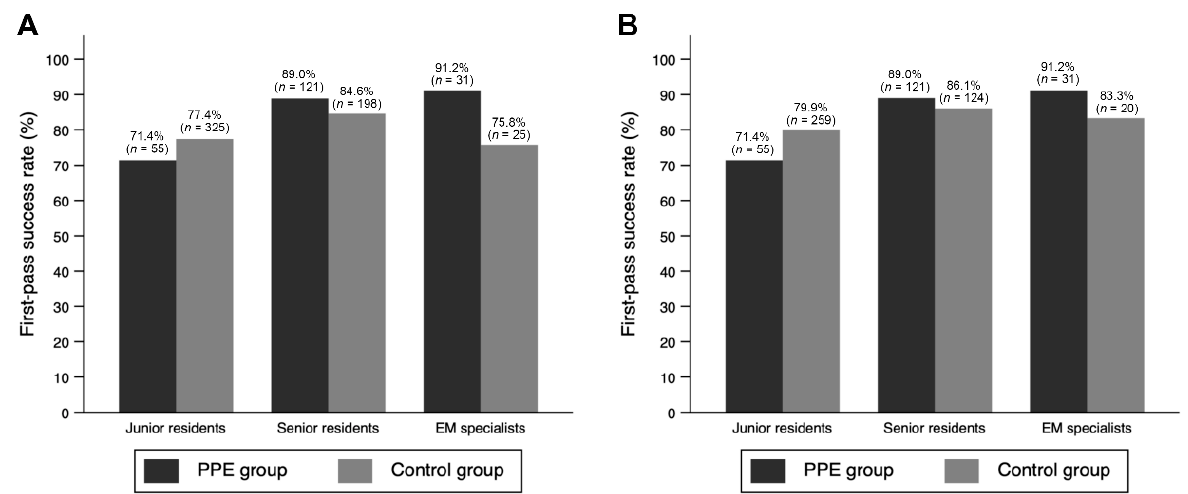
Figure 2. Comparison of the first-pass success rate according to the level of the intubator. ( A ) Before matching. ( B ) After matching. PPE, personal protective equipment; EM, emergency medicine. Table 2. Primary and secondary outcomes.